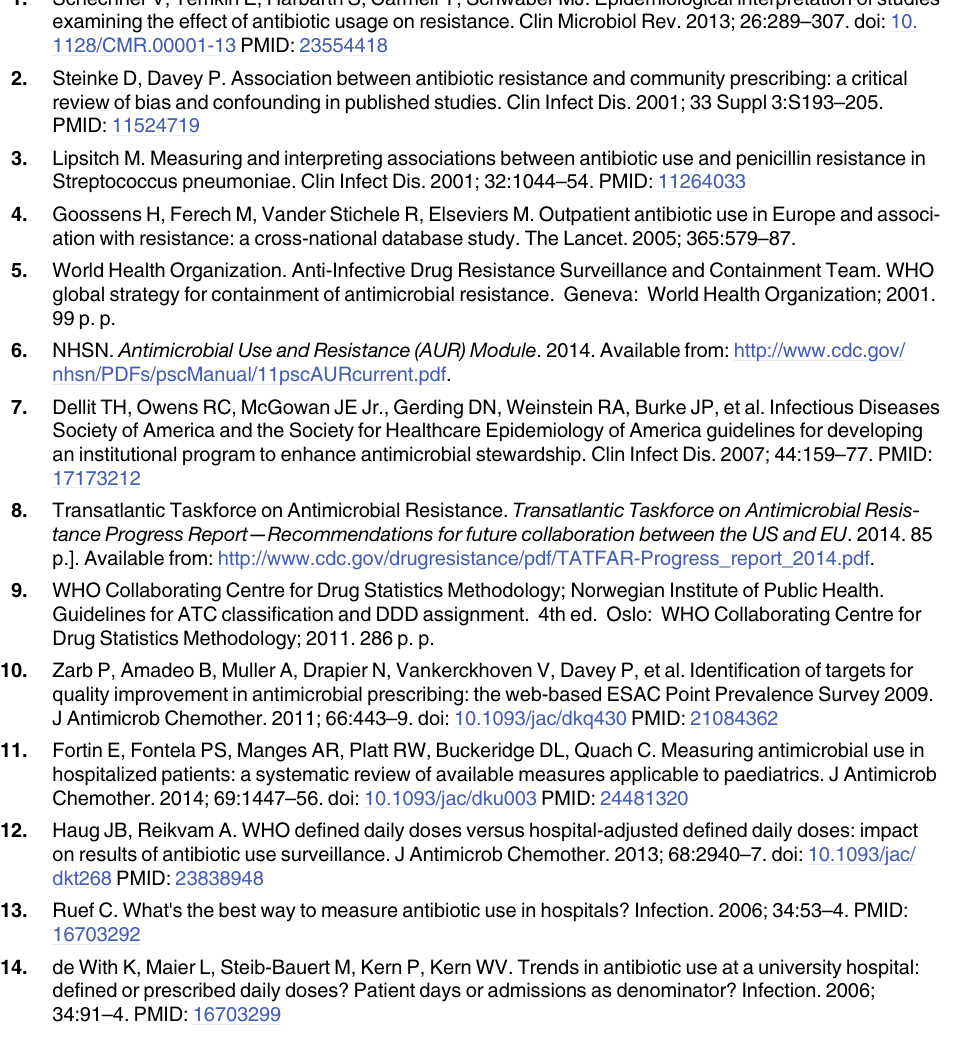
S4 Table. Most accurate, second most accurate and least accurate indicators in predicting incidence rates of antimicrobial resistance, for different scenarios, with their regression link and their mean absolute error, stratified per ICU type as adjusted for in regression